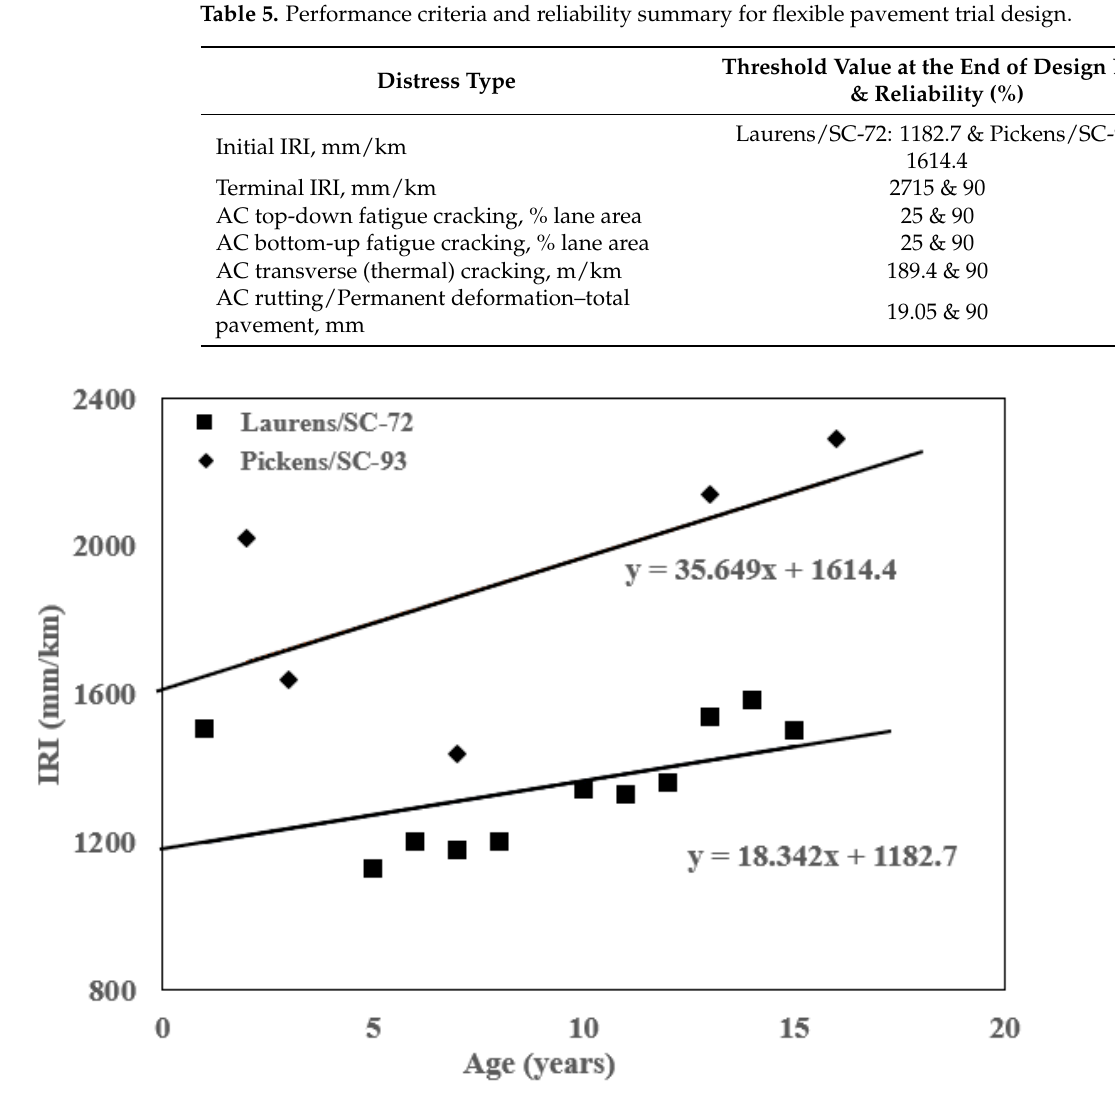
Figure 8. Initial IRI estimation for Laurens/SC-72 and Pickens/SC-93.